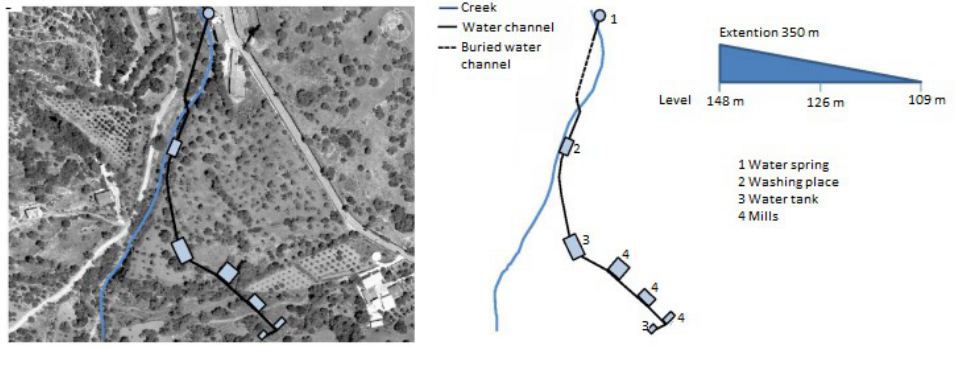
Figure 9: Image of a small valley near Cerro de S˜ao Miguel, Northeast Faro